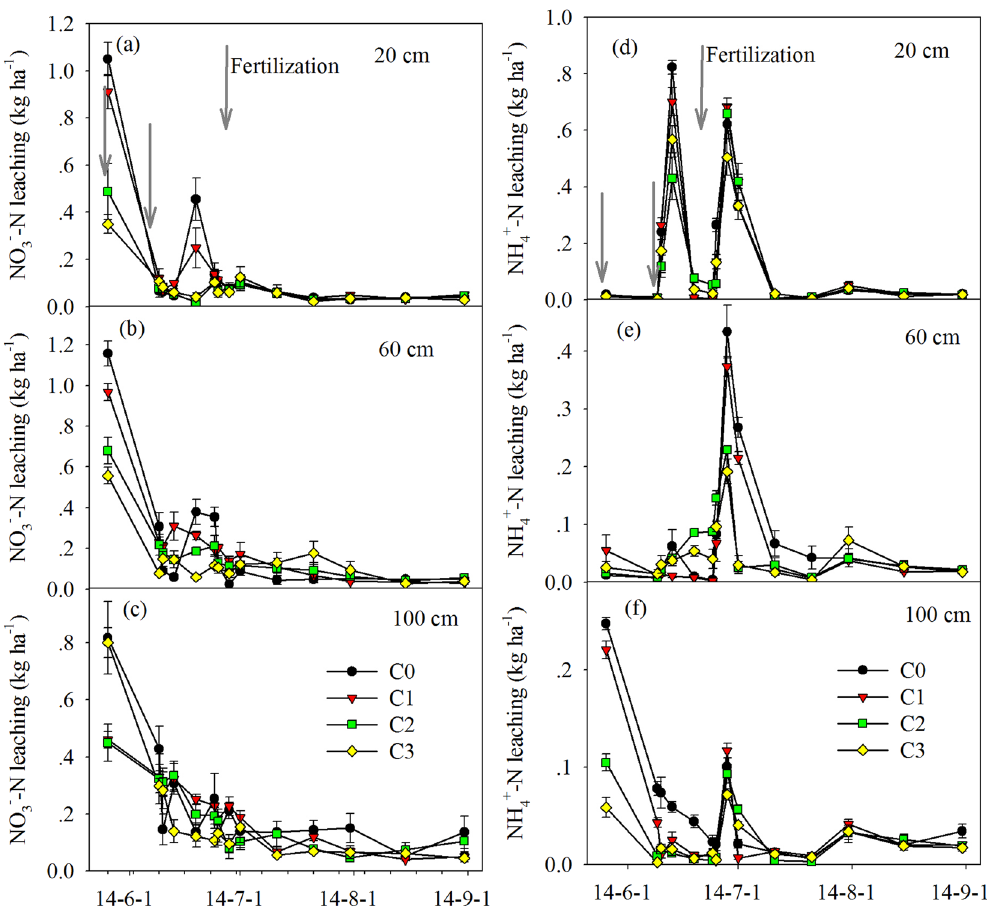
Figure 2. Variation of soil NO 3 − -N ( a – c ) and NH 4 + -N ( d – f ) leaching under the four experimental treatments. Data are shown as means with standard errors.